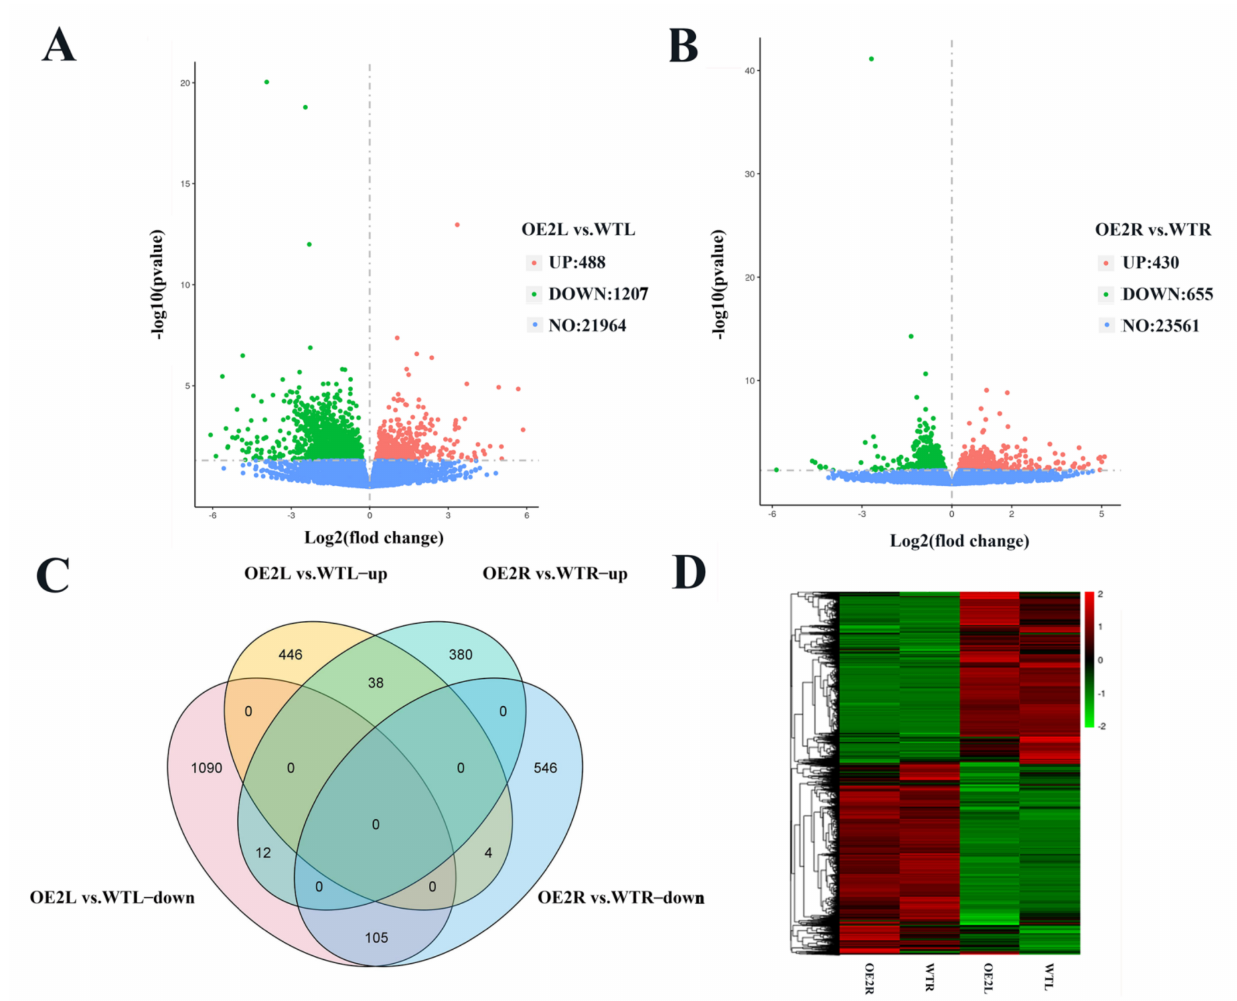
Figure 6. The landscape of CsSDG36 transcriptional regulation in Arabidopsis thaliana . ( A ) Filter-Volcano plot of overex- pression lines vs. the wild-type line in leaves (log2 (fold change)). ( B ) Filter–Volcano plot of overexpression lines vs. the wild-type line in roots (log2 (fold change)). ( C ) Venn analysis of overexpression lines vs. the wild-type line in leaves and roots about downregulated genes (DRGs) and upregulated genes (URGs). ( D ) Hierarchical clustering analyses of differentially expressed genes (DEGs): downregulated genes (DRGs) and upregulated genes (URGs) between wild-type (WT) and overexpression line 2 in leaves and roots. Heat color gradation in red and green denotes an increase and a decrease, respectively. OE2, overexpression line 2. Error bars indicate mean ± SD ( n = 3). The results were obtained from three biological